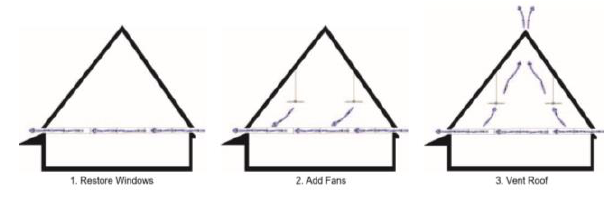
Figure 11. Ventilation